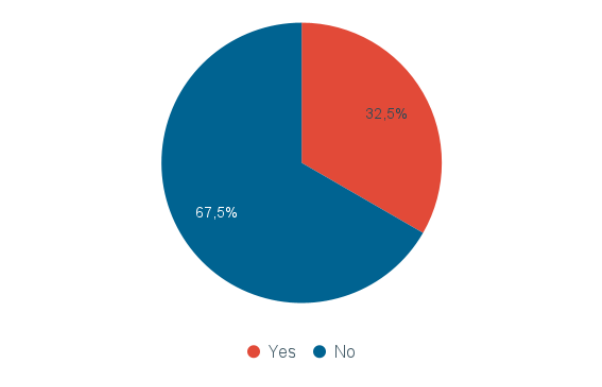
Figure 18. Did you know Ada Lovelace before the game? - Test 1.